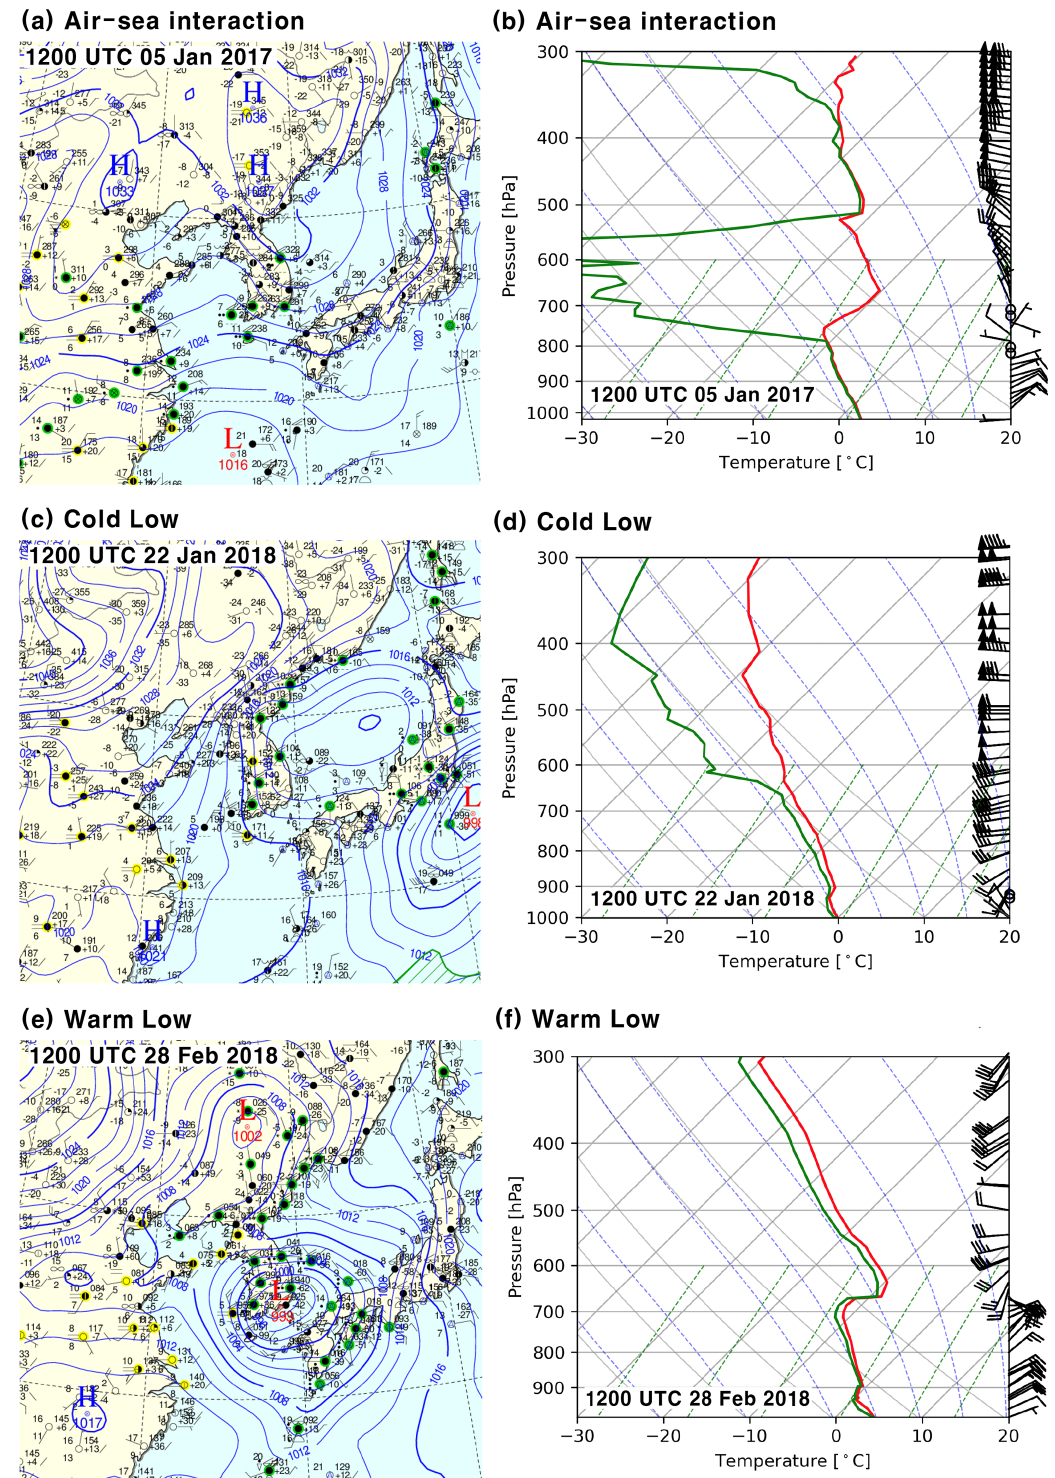
Figure 2. (a, c, e) Surface weather chart from the KMA for (a) air–sea interaction, (c) cold-low, and (e) warm-low types. (b, d, f) The radiosonde data plotted on a skew T -log p chart in a coastal area (Gangwon regional weather administration, GWW, near GWU) for (b) air– sea interaction, (d) cold-low, and (f) warm-low types. The skew T -log p chart was created using the MetPy package (May et al., 2008–2021) in Python. The red (green) solid line represents the temperature (dew point